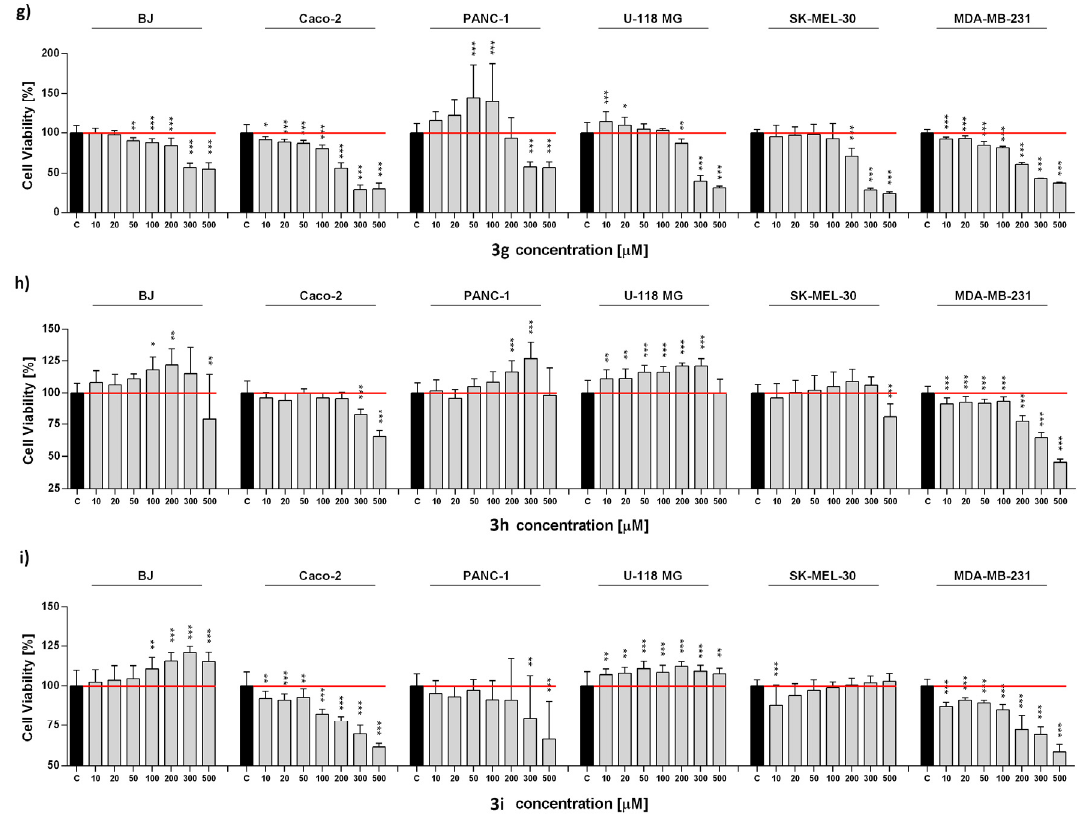
Figure 4. ( a – i ) Cell metabolic activity changes in normal and cancer cell lines. Cells were treated with different compounds ( 3a – 3i ) in a wide range of concentrations for 72 h, and viability was assessed by MTS assay. Bars indicate mean value and SD, n = 8, *** p < 0.001, ** p < 0.01, * p < 0.05 (one-way ANOVA and Dunnett’s a posteriori test). For the numerical results, see S28 point in Supplementary Materials (SI) section.